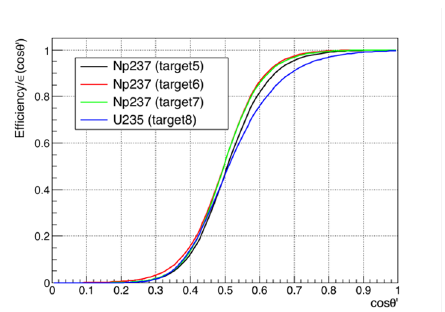
Figure 10: Fit of the angle dependence of the e ffi ciency for each sample. Three 237 Np samples are represented and one 235 U used as the cross section reference for determin- ing the neutron flux.